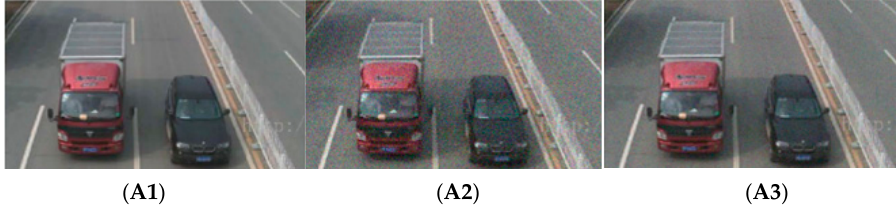
Figure 14. Vehicle images: model performance trained with 180 × 180 image size. ( A1 ) The original image; ( A2 ) the noisy image; ( A3 ) denoised image with σ = 10 .